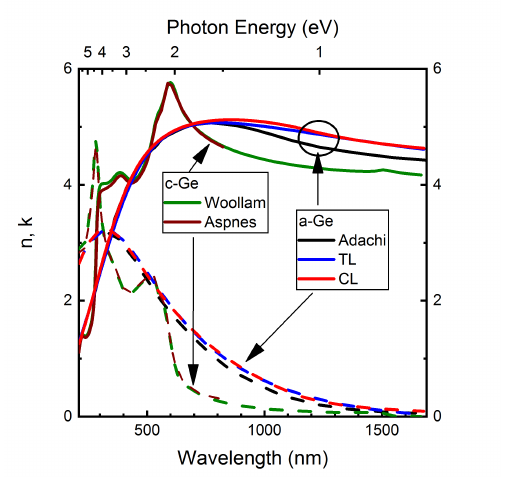
Figure 6. n (solid lines) and k (dashed lines) spectra given by the evaluation of the measured SE data using the CL and TL dispersions. For comparison, the data of c-Ge [28,30] and evaporated a-Ge [15] (Adachi) are also